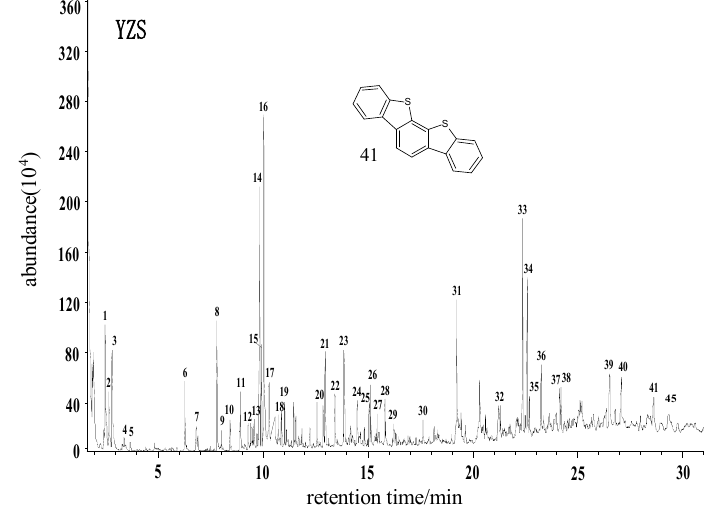
Figure 3. Total ion chromatogram (TIC) of THF extract of YZS coal samples.